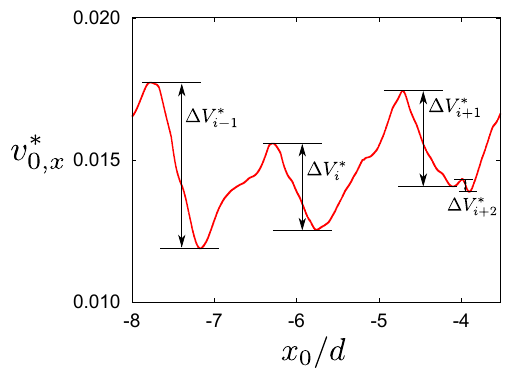
Figure 6. Typical velocity evolution against the position of the object for D = 10 d , ϕ = 0 . 80, and F drag = 2 . 5 × 10 − 2 k n d . The ve- locity drop ∆ V i is defined by the region where the slope of the ve- locity is negative. Here, we have introduced v ∗ √ ≡ ∆ V k n / m ). and ∆ V ∗ i / ( d i